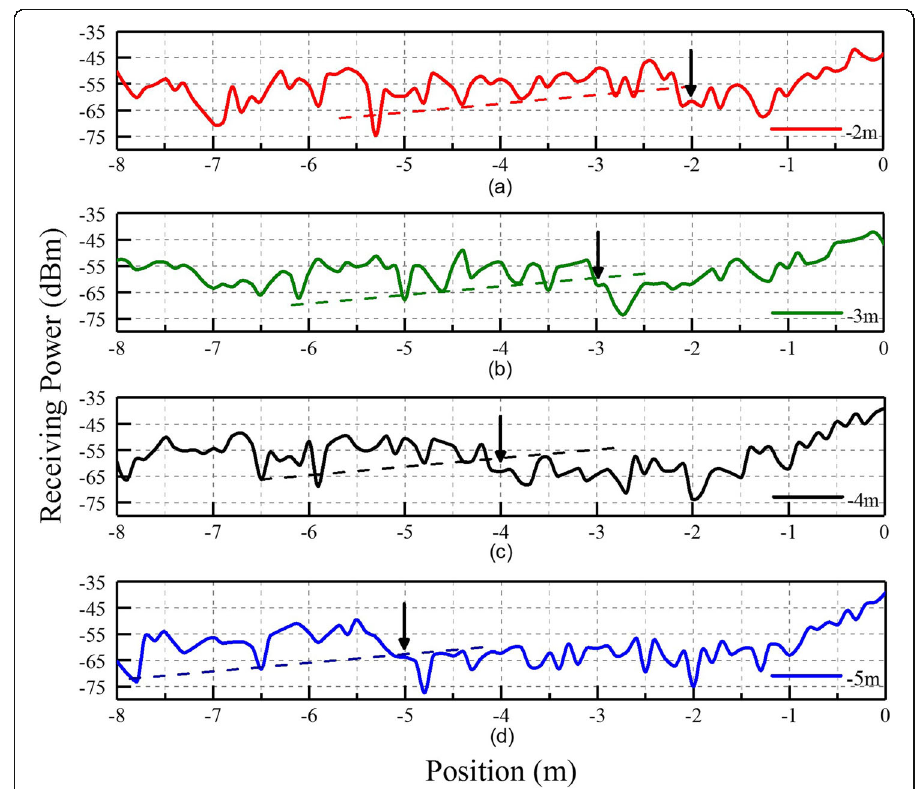
m, as indicated by black arrows